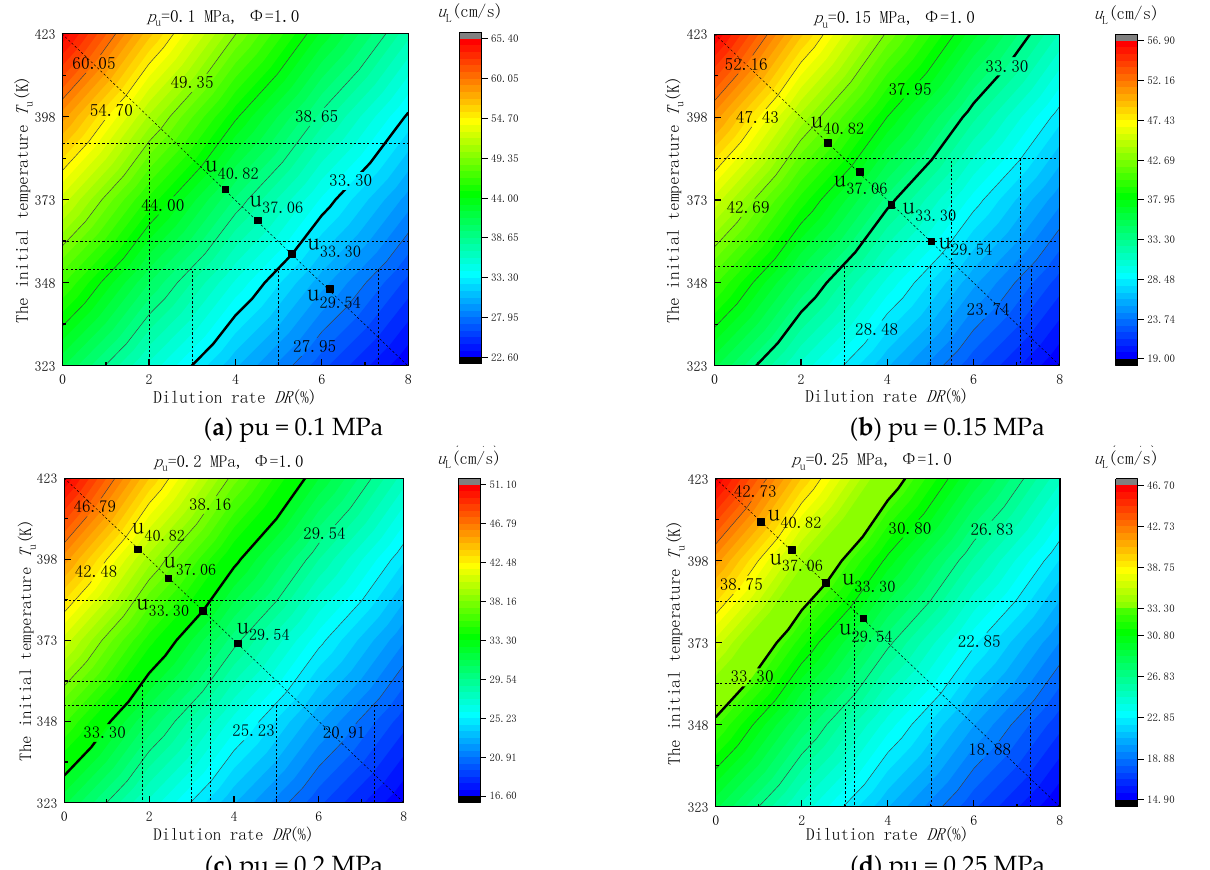
Figure 10. Equivalent distribution pattern of u L under the coupling effect of Tu and DR when Φ is 1.0 and when the initial pressures are 0.1 MPa, 0.15 MPa, 0.2 MPa and 0.25 MPa.